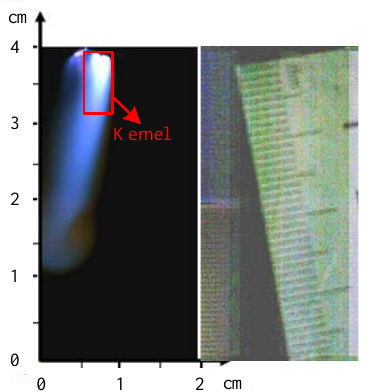
Figure 6. Plasma jet flow size at t = 2.4 ms.